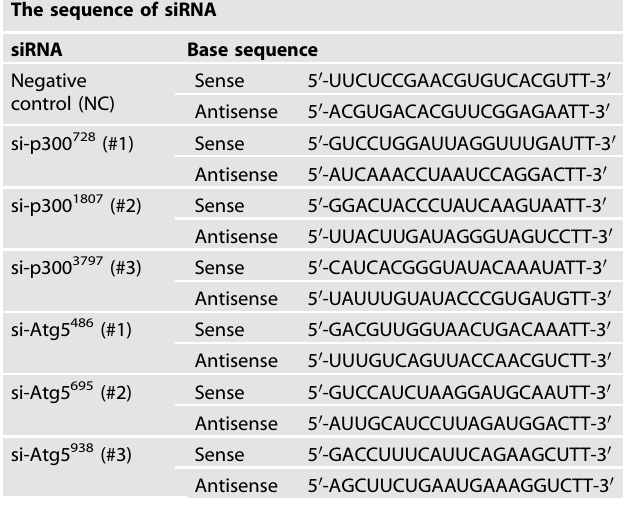
Table 1. The chain of interference for transfection cells. The sequence of